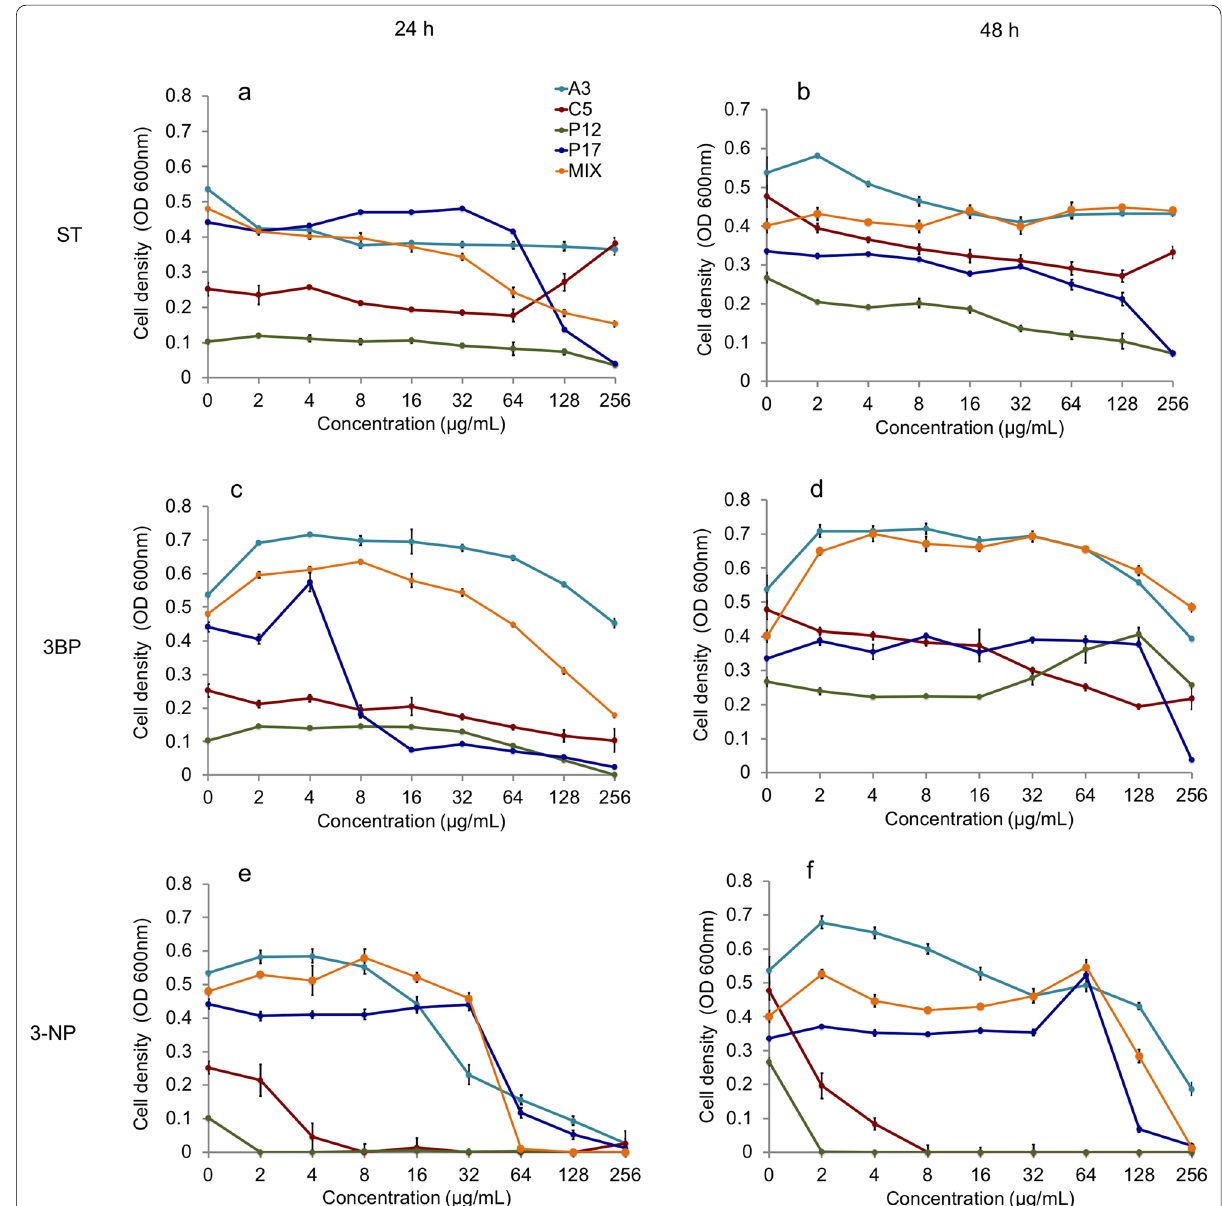
Fig. 3 Cell density of monoculture (A3, C5, P12, and P17) and four species (MIX) culture with different metabolic inhibitors after 24 and 48 h. a Measurement of cell density with gradient concentrations of ST (sulfathiazole) (24 h). b Measurement of cell density with gradient concentrations of ST (48 h). c Measurement of cell density with gradient concentrations of 3BP (3-bromopyruvic acid) (24 h). d Measurement of cell density with gradient concentrations of 3BP (48 h). e Measurement of cell density with gradient concentrations of 3-NP (3-nitropropionic acid) (24 h). f Measurement of cell density with gradient concentrations of 3-NP (48 h). n =